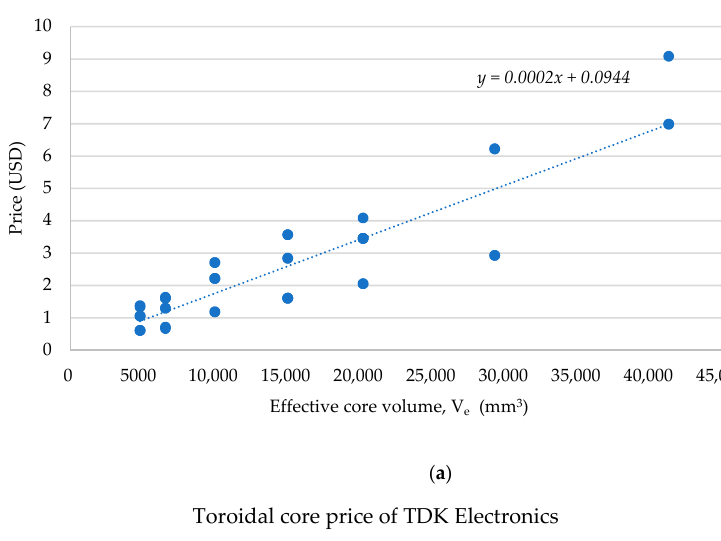
y = 0.0005x + 0.1267